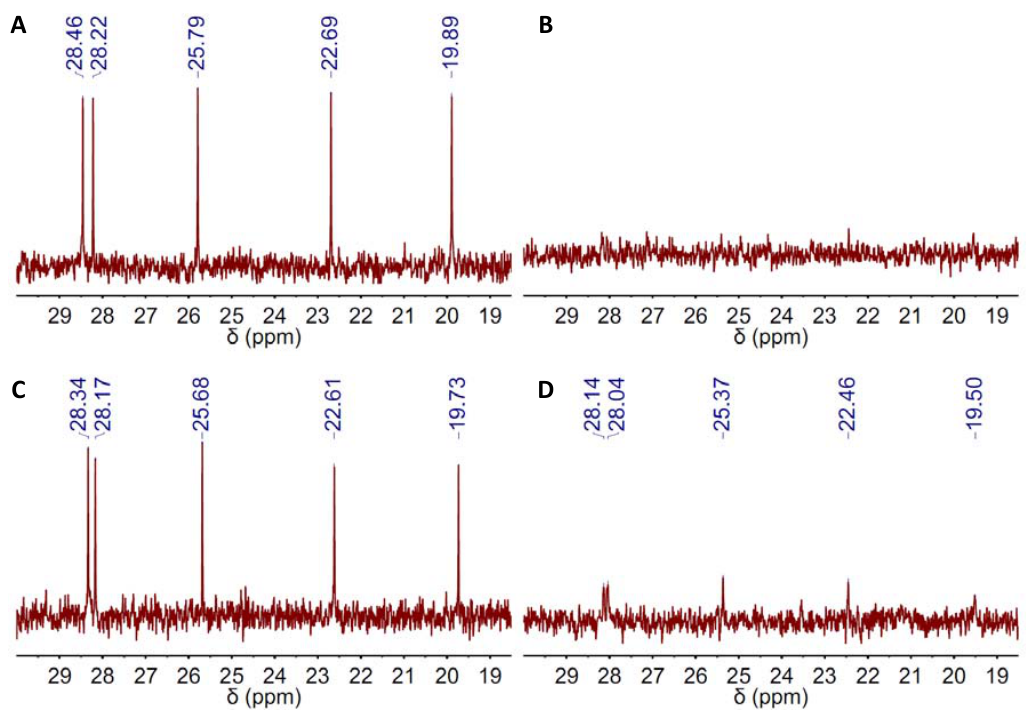
Figure 7. 13 C NMR spectra of the reaction mixture before and after submission of the reaction mixture to 100 ◦ C over 2 h in a 1.2-bar CO 2 atmosphere using either ( A , B ) DBU or ( C , D ) DBU(1):BA(1) DES as catalysts. The region of chemical shifts displayed in the spectra just ranged from ca. 20–30 ppm because neither EP, nor BA exhibit peaks at that